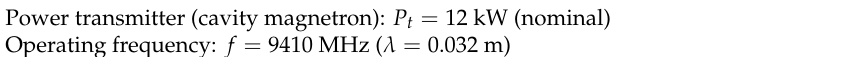
Table 1. Main parameters of the Navico/Simrad SRT radar.